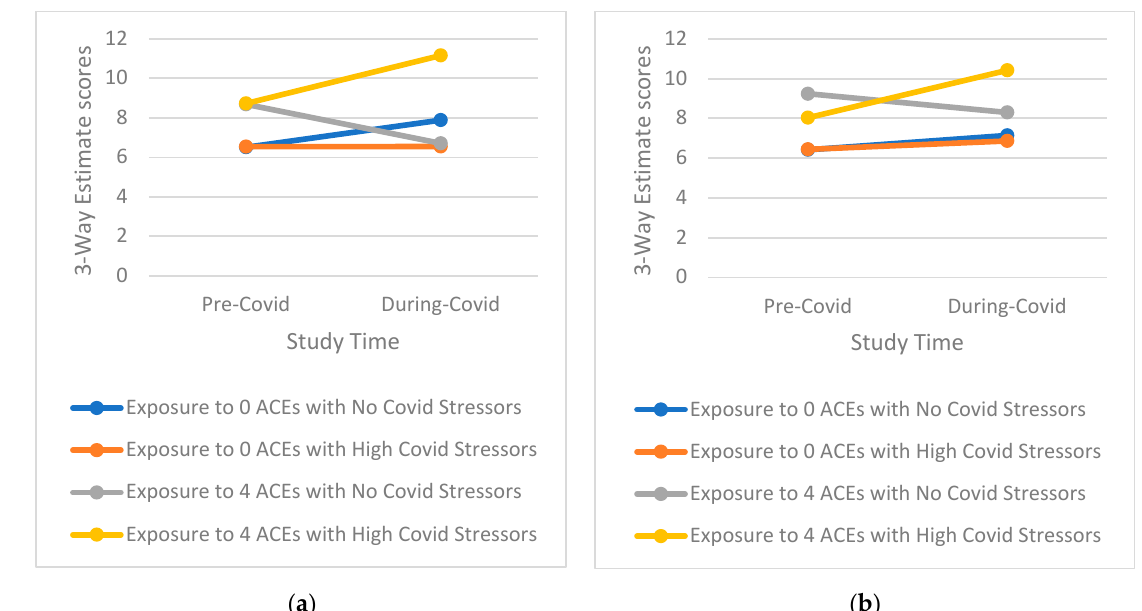
Figure 2. ( a ) Interaction of greater exposure to ACEs and high levels of Loneliness on Changes in Anxiety Symptomatology among Young Adults from Before to During the COVID-19 Pandemic; ( b ) Interaction of greater exposure to ACEs and high levels of Suspiciousness on Changes in Anxiety Symptomatology among Young Adults from Before to During the COVID-19 Pandemic.